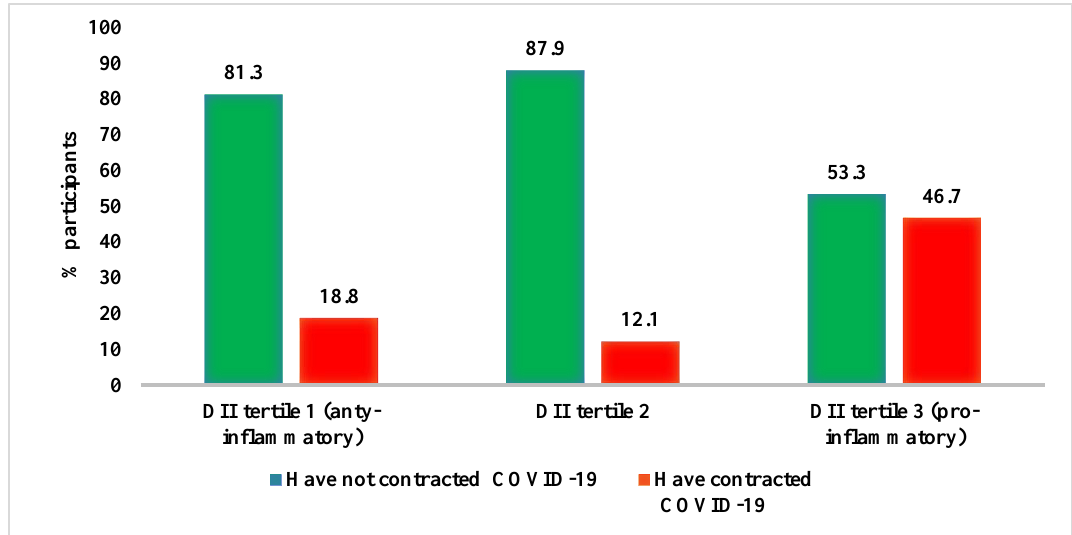
Figure 1. Incidence of COVID-19 according to the POLA index. The percentage of participants who contracted and did not contract COVID-19 ac- cording to DII tertiles is shown in Figure 2.